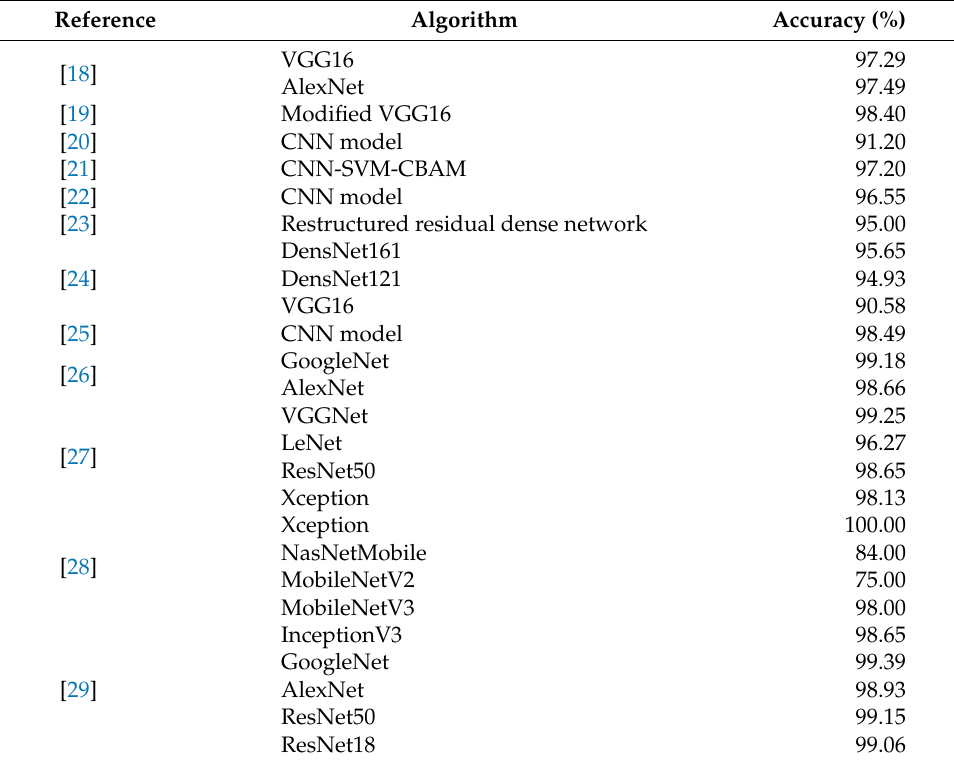
Table 1. A comparison of the several tomato crop